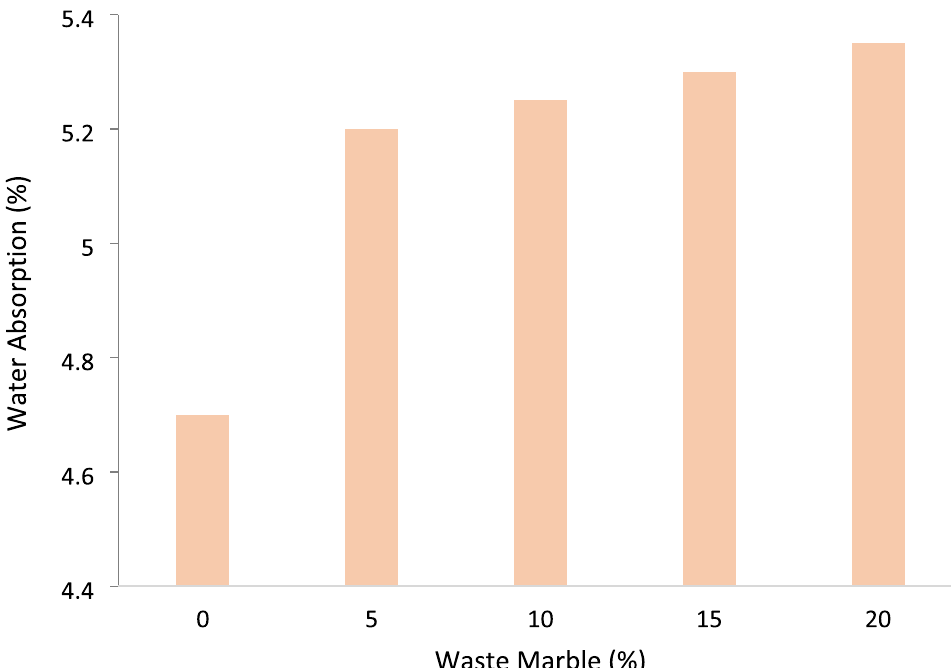
Fig. 14 Water absorption (Boukhelkhal et al.,